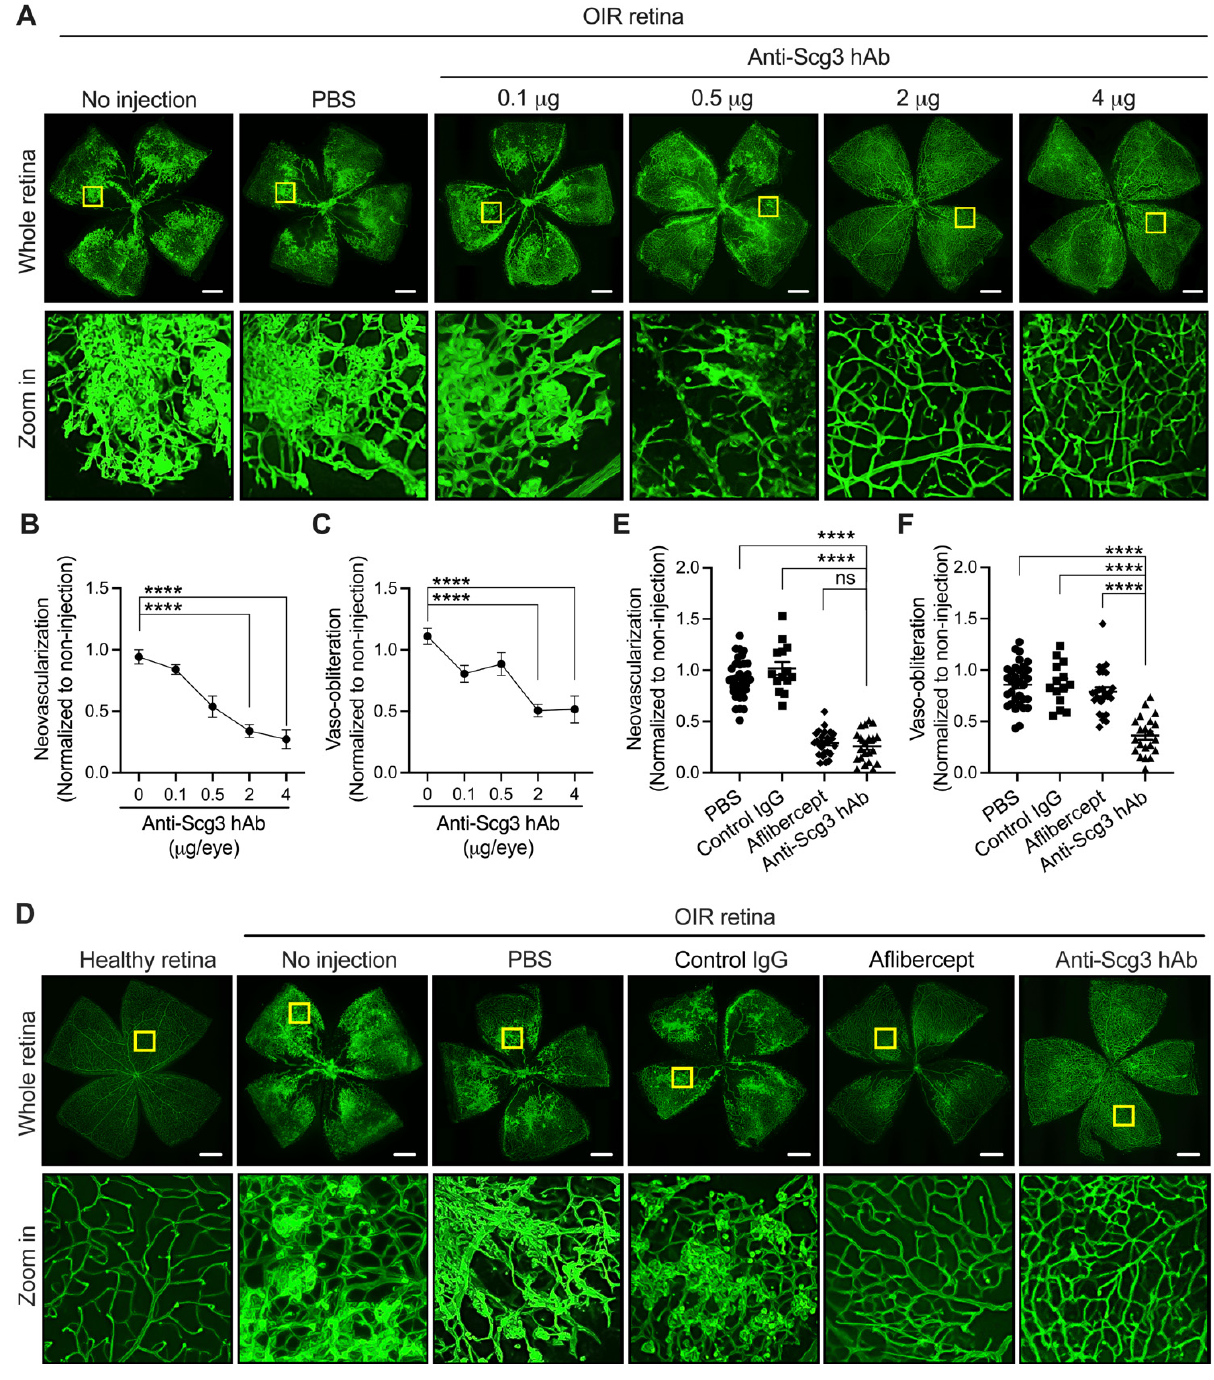
Figure 1. Intravitreal administration of anti-Scg3 hAb inhibits pathological RNV and reduces central avascular area in OIR mice. ( A ) Flat-mount retinas of OIR mice treated with anti-Scg3 hAb at 0.1, 0.5, 2, or 4 µg/0.5 µL/eye. Retinal vessels were stained with AF488-IB4. Yellow box corresponds to the magnified area below, showing changes in vascular pattern. ( B ) Quantification of RNV in ( A ). ( C ) Quantification of the central avascular area in ( A ). n = 8 eyes (0, 0.1, and 2 µg) and 6 (0.5 and 4 µg) in ( B , C ). ( D ) Flat-mount retina of OIR mice treated with different reagents (2 µg/0.5 µL/eye). ( E ) Quantification of RNV in ( D ). ( F ) Quantification of the central avascular area in ( D ). n = 33 eyes (PBS), 14 (control IgG), 26 (aflibercept) and 21 (anti-Scg3 hAb). Mean ± SEM; **** p < 0.0001; ns, no significance. one-way ANOVA test. Scale bar = 500 µm (whole retina).